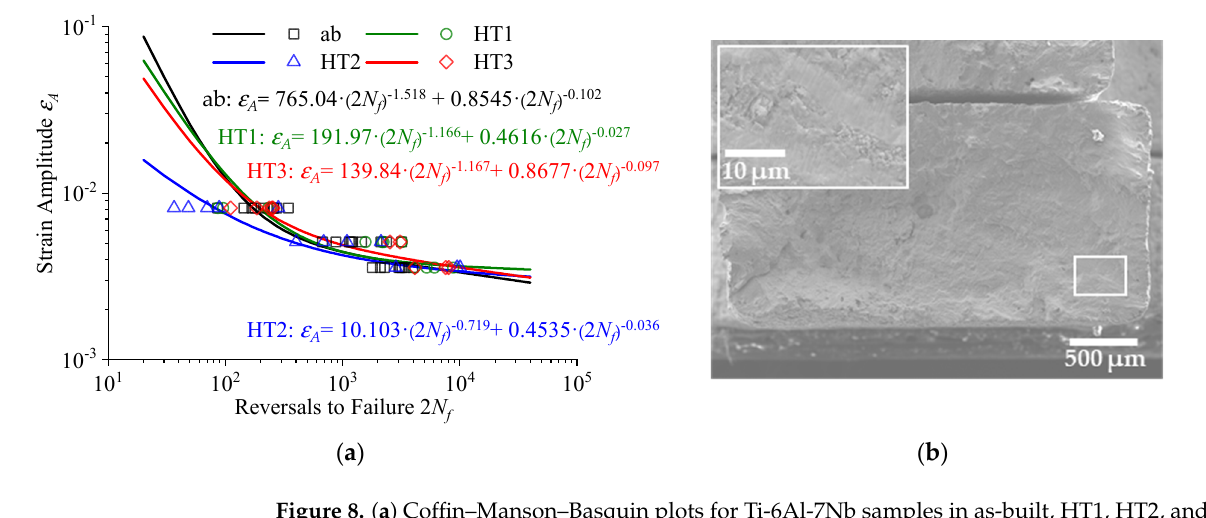
Figure 8. ( a ) Coffin–Manson–Basquin plots for Ti-6Al-7Nb samples in as-built, HT1, HT2, and HT3 conditions; ( b ) SEM images of a fracture surface of an as-built Ti-6Al-7Nb fatigue specimens, with fatigue striations, probably oriented perpendicular to the crack growth direction.